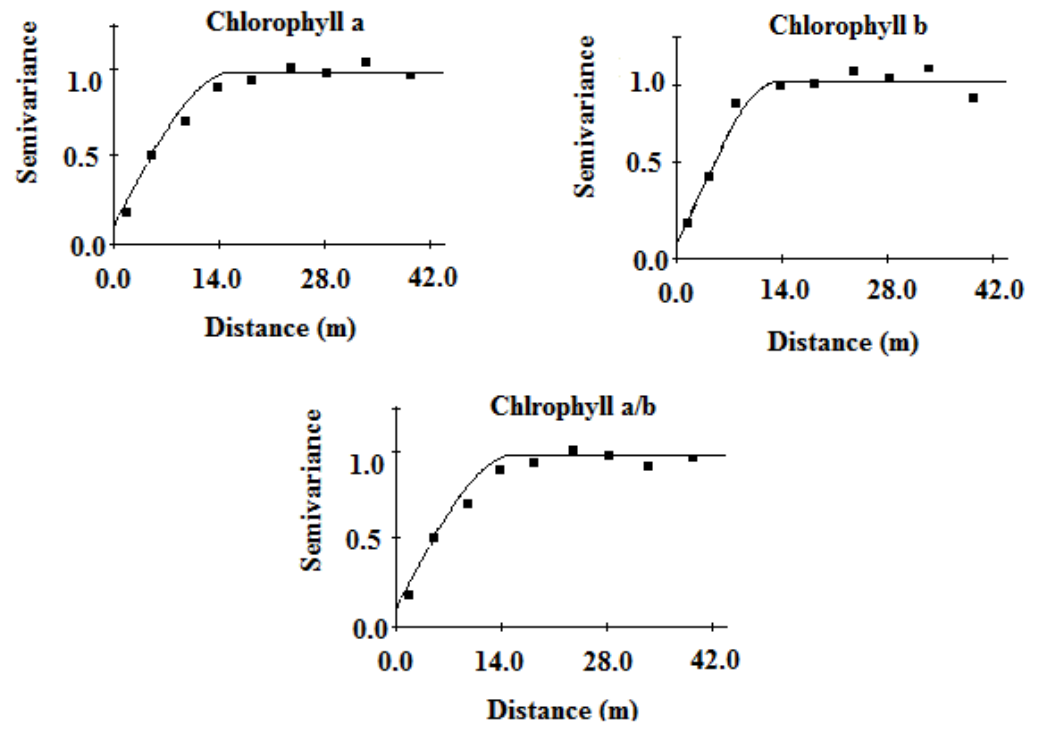
Figure 3. Standardized theoretical semivariograms for leaf chlorophyll index (LCI).